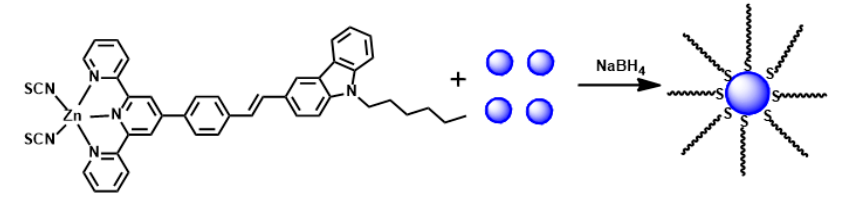
Figure 8. The synthesis route of S-Au NPs ( 51 ). Table 4. Open- and closed-aperture Z-scan measurement data for the third-order nonlinearity parameters of S, S-Au NPs ( 51 ) in DMF with 10 − 3 M concentration.